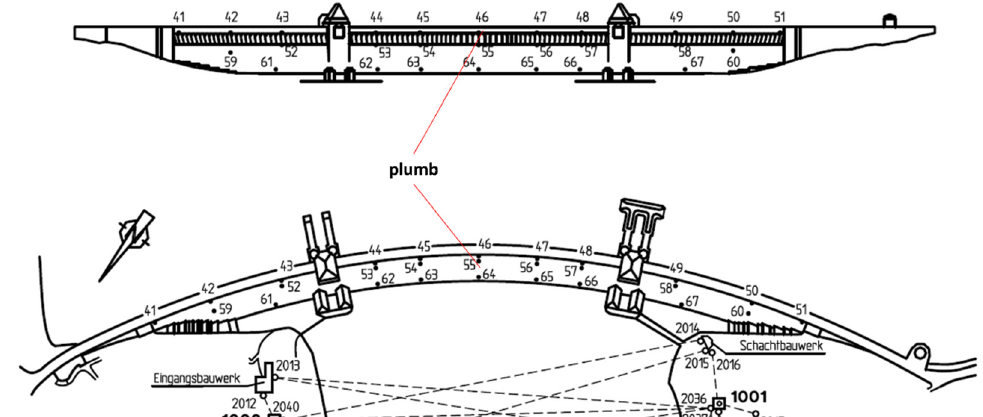
Figure 3. Spatial distribution of the trigonometric measurements (Object Points—OP) across the Moehne Gravity Dam. The 27 Object Points are numbered from 41 to 67 [2].